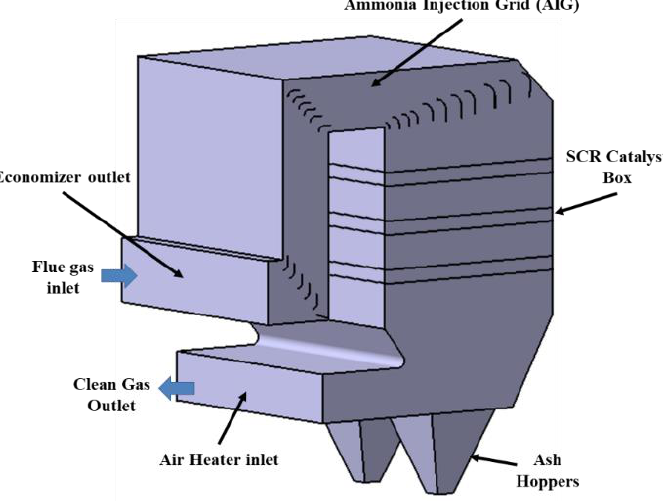
Figure 2. Set up of DeNO x facility in Samcheonpo thermal power